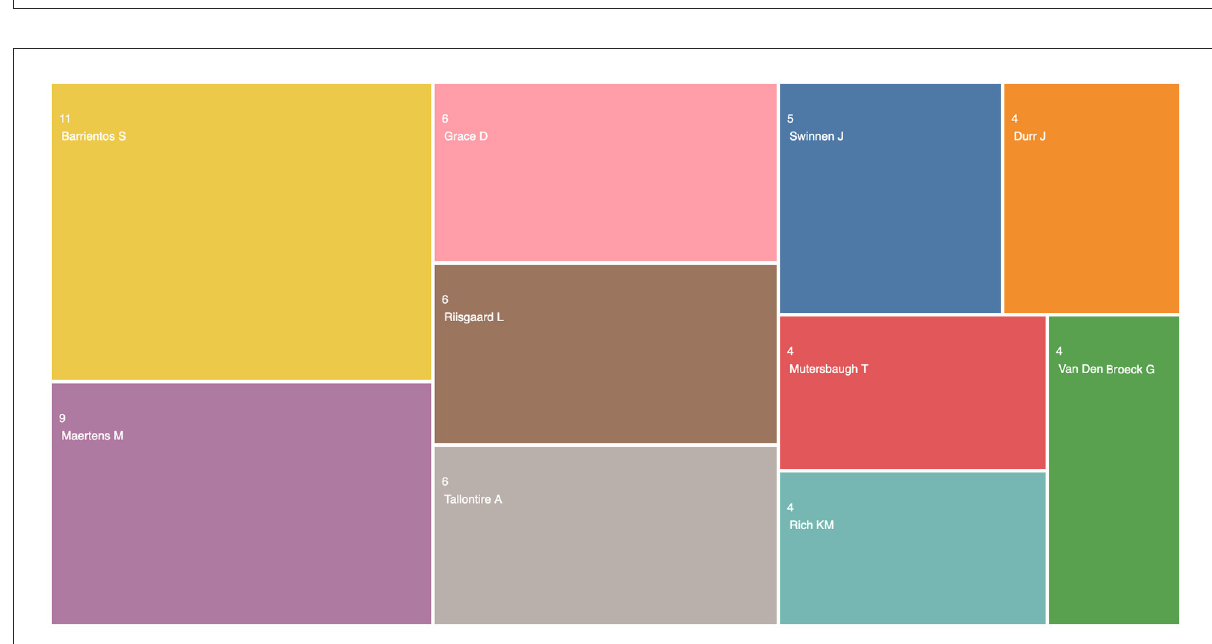
such as sustainability, food quality and safety. The highlighted empirical studies are related to diverse of agri-food value chains (e.g., livestock, flower, coffee, banana, aquaculture) in African countries (e.g., Kenya, Tanzania, Ethiopia, Egypt), and rice value chain in Asian countries (e.g., Asia,